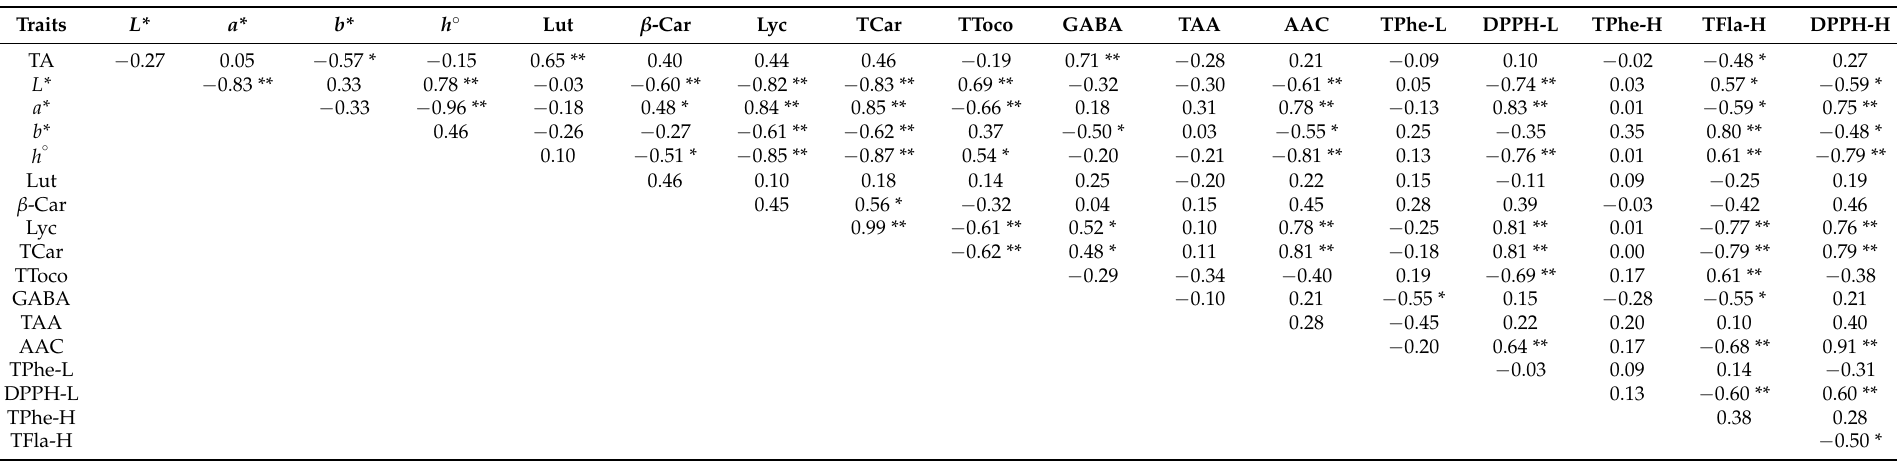
Table 5. Pearson’s correlation coefficients of the contents of antioxidant constituents and antioxidant activities of tomato pulp with skin from 18